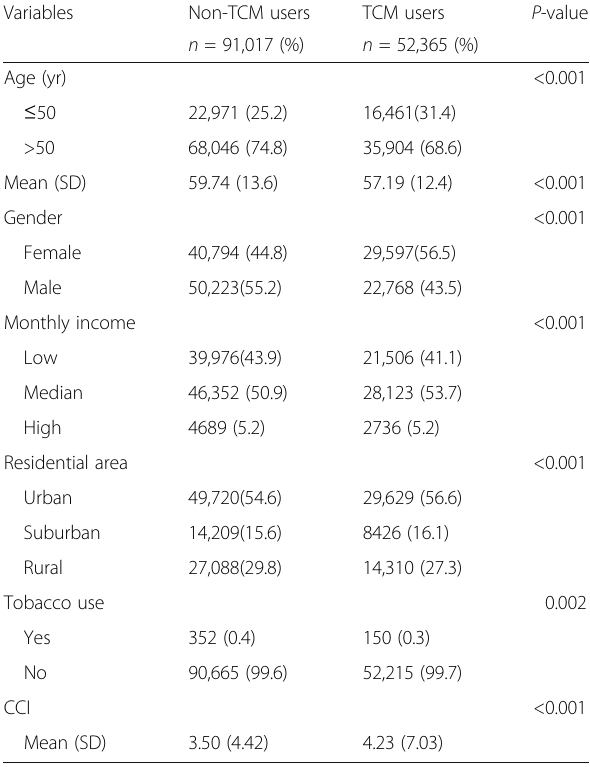
Table 1 Demographic data and selected comorbidities of the study subjects